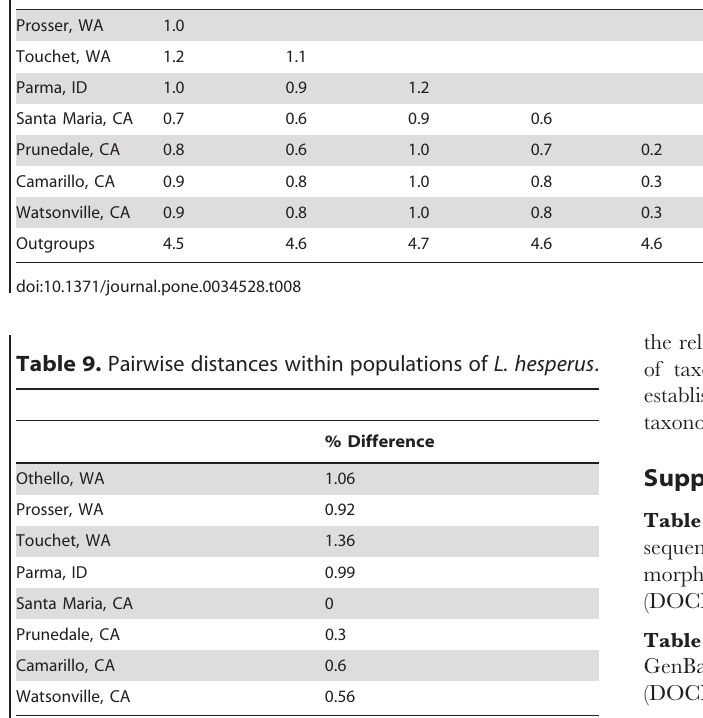
Table S1 Genbank accession numbers of the 21 mtCOI sequences used in the alignment for the Heteropteran: Cimici- morpha mtCOI primers designed in this study. Table S2 GenBank Accession numbers. A list of the individual GenBank Accession numbers for each haplotype.